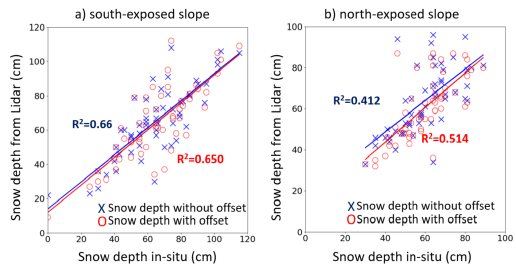
Figure 9 . Snow depths before and after the application of the offset for the south (a) and north (b) exposed